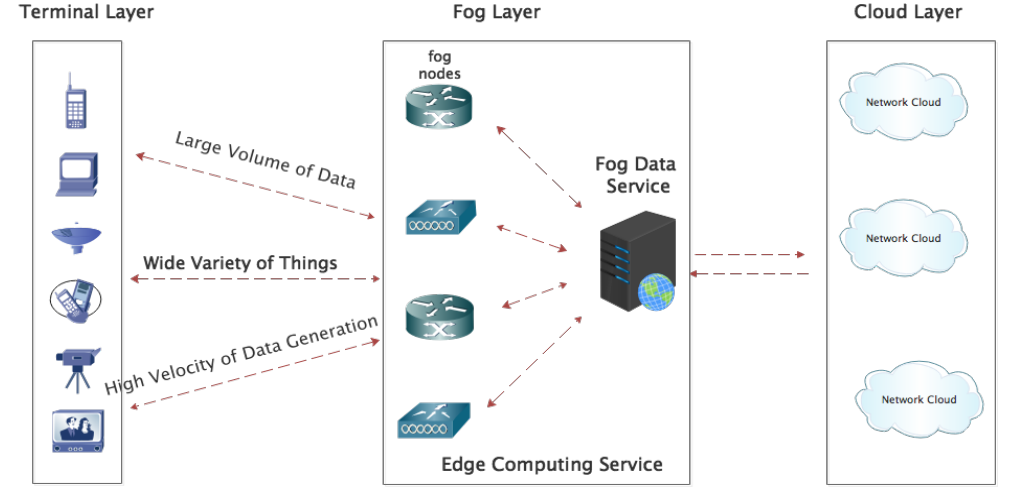
Figure 1. The model of the internet of things